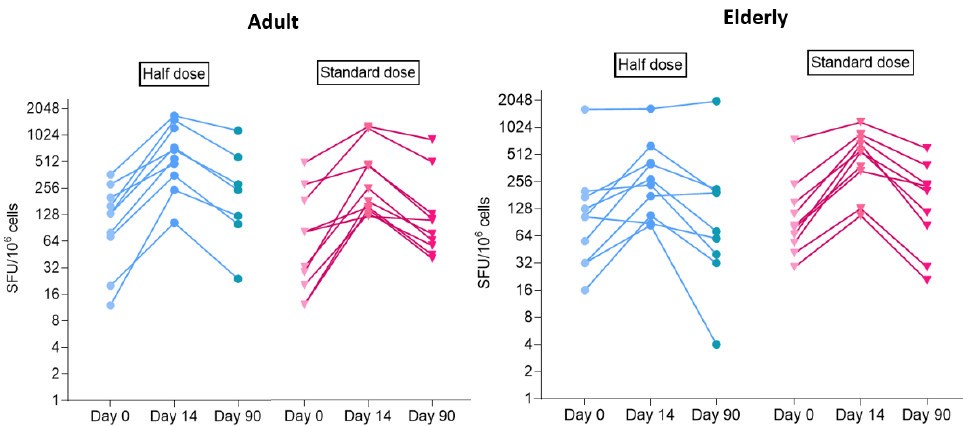
Figure 3. IFN γ ELISpot assay to detect S peptide ‐ specific T ‐ cell responses, presented as the median (IQR), at day 0 (before BNT162b2 booster doses), day 14, and day 90 after booster doses in adults post ‐ 2 doses of AZD1222, according to half ‐ dose and standard ‐ dose groups. SFU: spot forming unit; S: Spike of SARS ‐ CoV ‐ 2. Adult: age 18–59 years; Elderly: age 60–69 years.